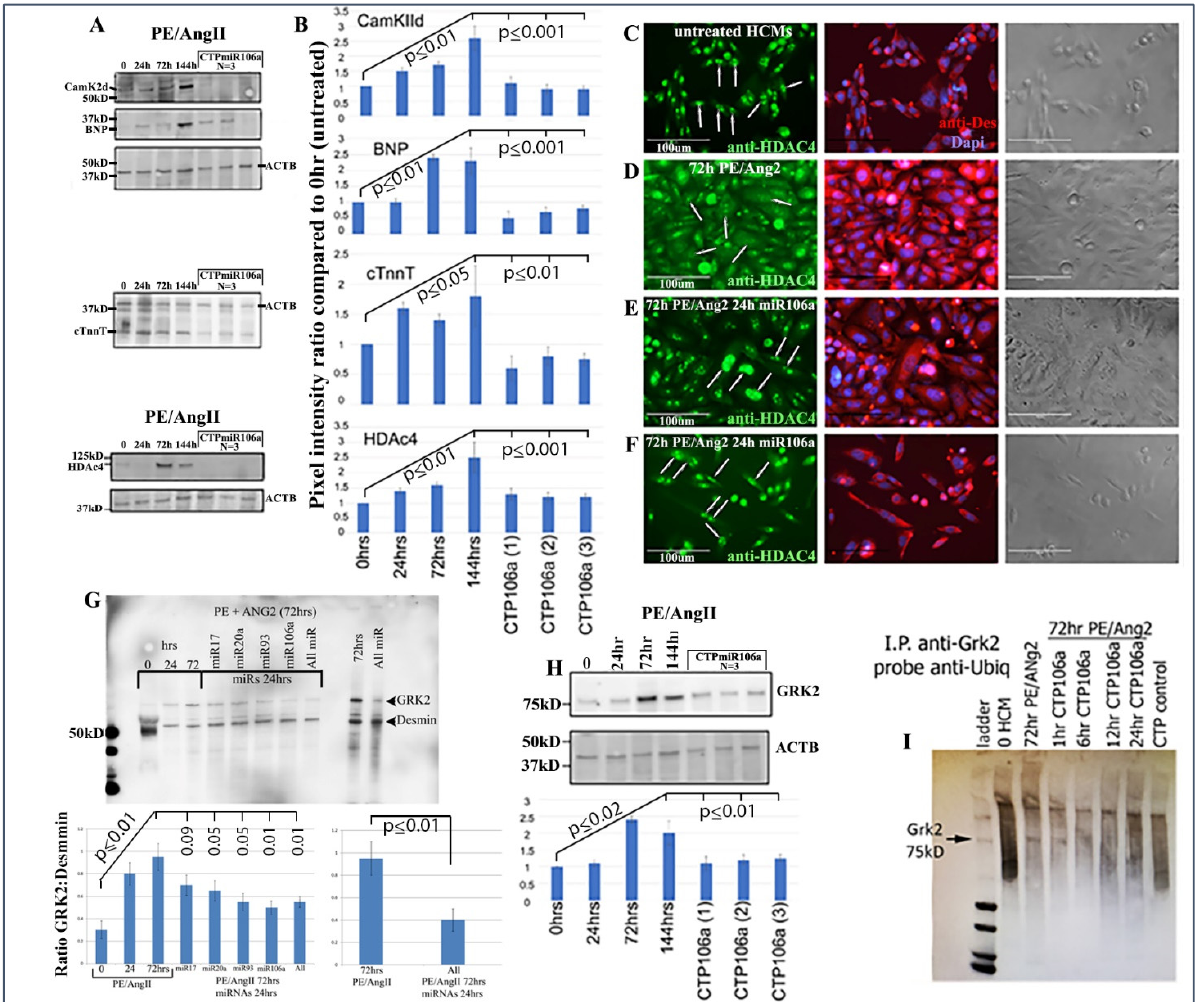
Figure 4. CTPmiRNA106a reverses PE/Ang2-induced hypertrophic responses. ( A ) PE/Ang2 induces expression of CamKII δ , HDAc4, BNP, and cTNNT, while CTPmiRNA106a suppresses and returns an expression of these proteins to normal (untreated) levels. ( B ) Graphs are culminated from at least six experiments. Significance (at least p < 0.05) is observed between each CTPmiRNA106a-treated set and 144 h PE/Ang2-treated HCMs. No significance is observed between each CTPmiRNA106a and untreated HCMs. ( C – F ) HDAc4 is nuclear in untreated HCMs ( C -arrows). ( D ) PE/Ang2 induces CamKII δ resulting in HDAc4 translocation to the cytoplasm (arrows). ( E , F ) Transfection of miRNA106a ( E ) or culture in CTPmiRNA106a ( F ) reverses translocation of HDAc4 back to the nucleus (arrows). Note: compared to untreated cells ( C ), PE/Ang2 causes a marked increase in cell size ( D ), which is reversed after miRNA treatment ( E , F ). ( G ) GRK2 increases expression in response to PE/Ang2. Transfection using Trans IT-X2 of each miRNA or in combination reverses GRK2 expression back to untreated levels. ( H ) CTPmiRNA106a also reverses increased GRK2 expression caused by PE/Ang2. ( I ) Similar to [30], GRK2 antibody (Mouse) was used to immunoprecipitate GRK2 in HCMs. After blotting, anti-ubiquitin (rabbit) was used to identify ubiquitinated GRK2, which results in a smear of polyubiquitinated GRK2 (lane 2). Increase in CamKII δ after PE/Ang2 treatment results in less ubiquitination of GRK2 (Lane3), which increases as a result of CTPmiRNA106a suppression of CamKII δ over time. The CTP control lane is CTP without miRNA106a. All lanes were loaded with 500 ng of lysate measured using a Nanodrop machine. The experiment was done 3 times. Western Blot repeats can be found in Supplemental Figure